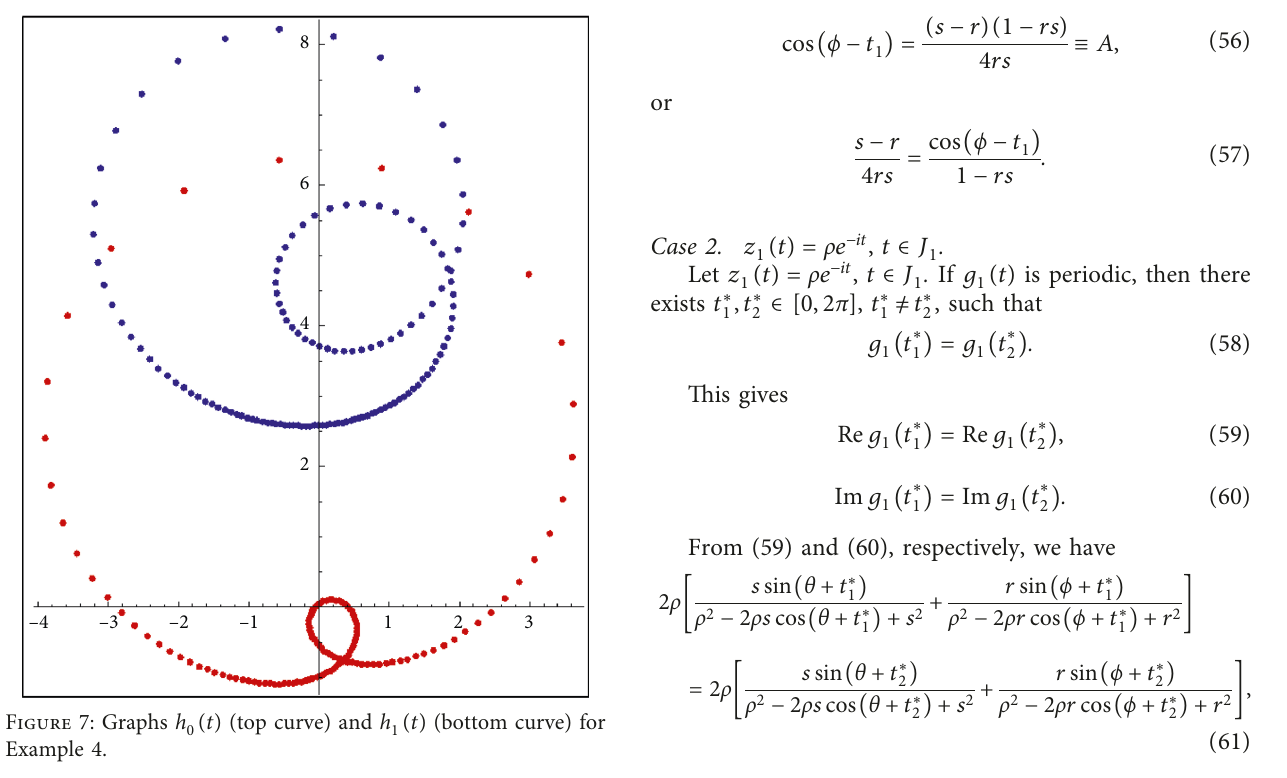
( t ) (bottom curve) for 1